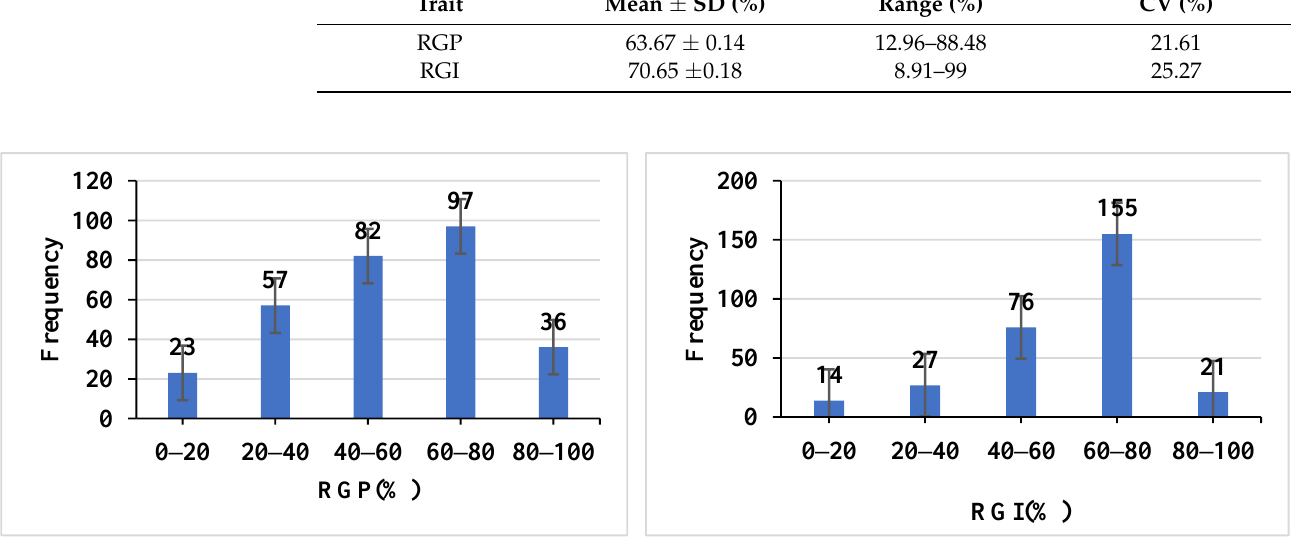
Table 2. Statistical analysis of RGP and RGI of 295 japonica rice accessions. Trait